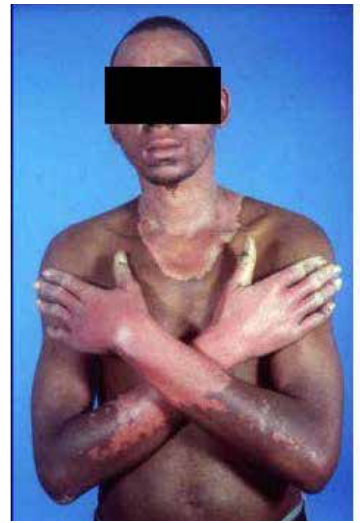
Figure 11. Photosensitive dermatitis in HIV. Note the distribution on sun exposed areas